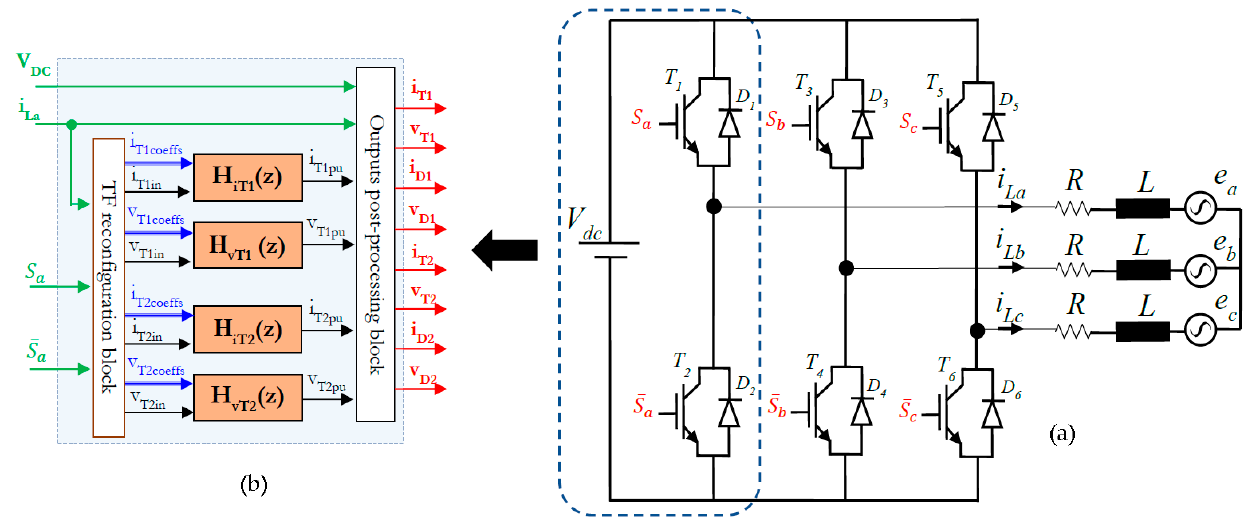
Figure 1. Overview of the proposed modeling approach—case of a 3-phase VSI. ( a ) Topology of a 3-phase VSI, ( b ) eRTS of an individual commutation cell. Lef-side of the figure is reprinted/adapted with copyright permission from [26].